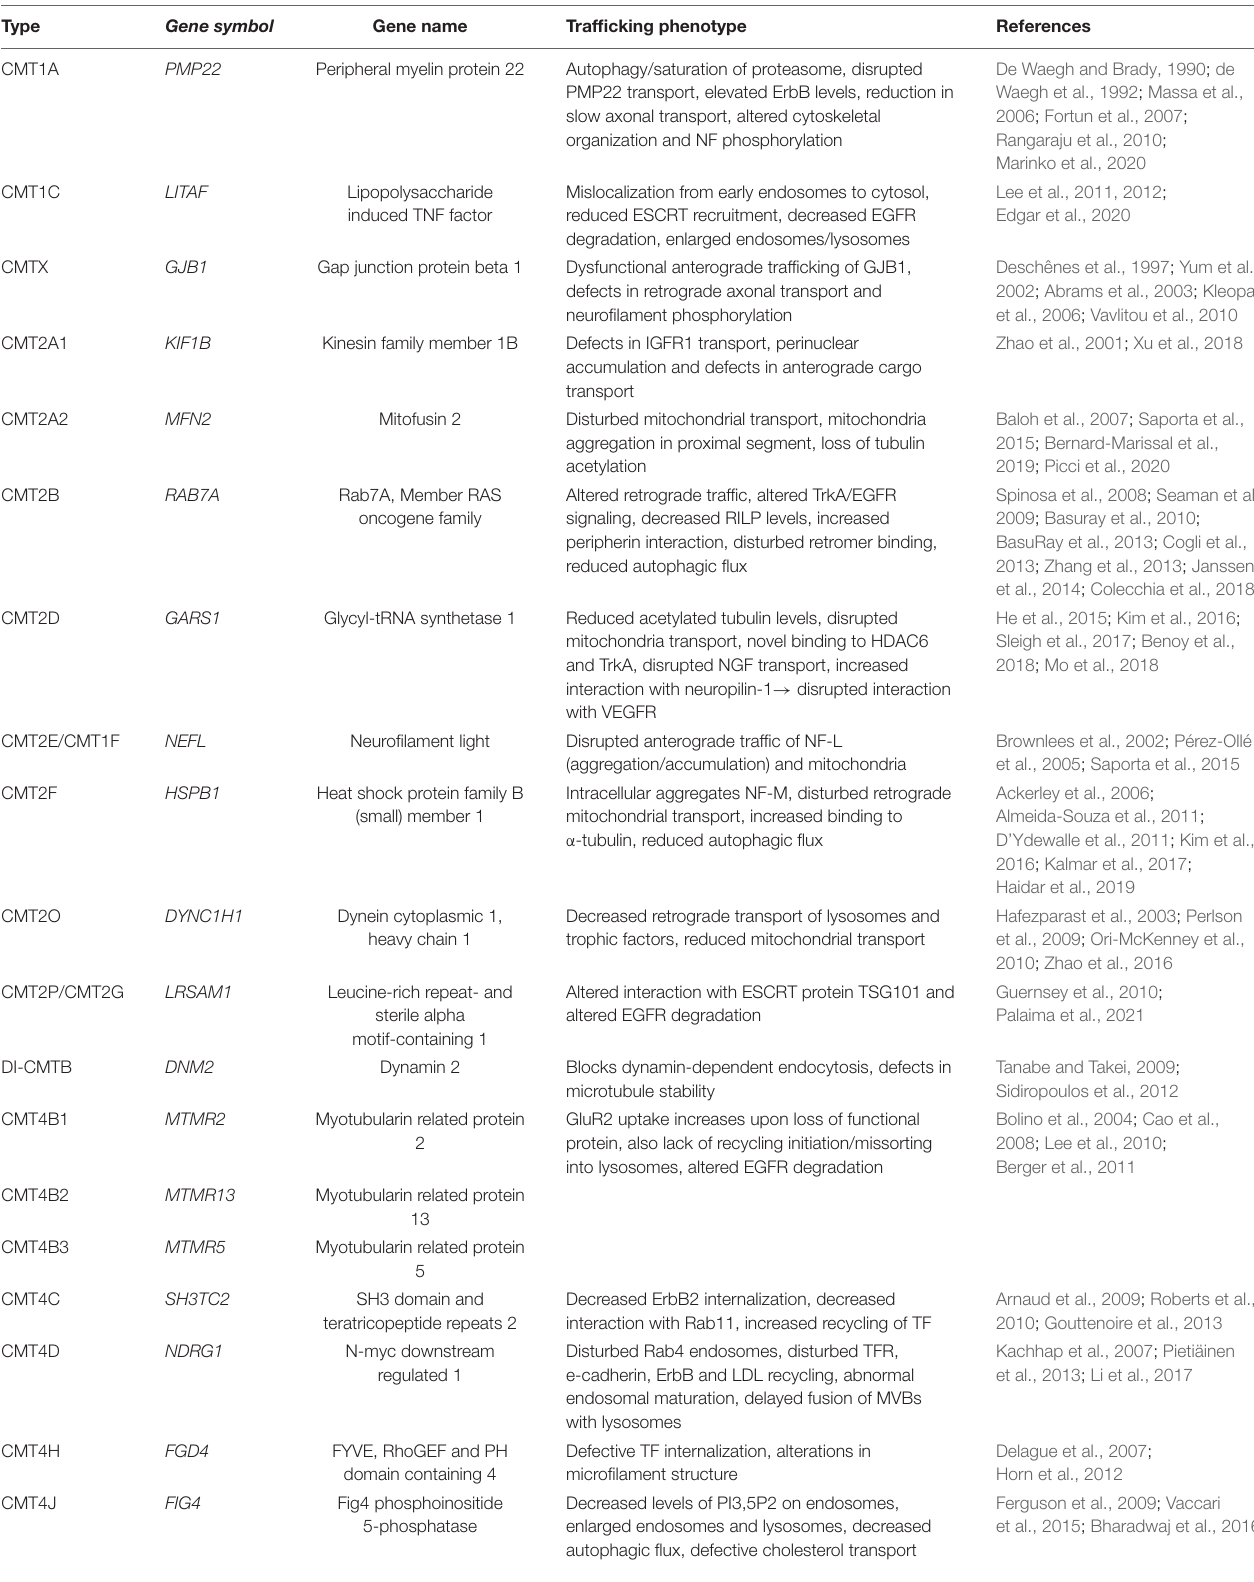
TABLE 1 | An overview of the CMT mutations involved in intracellular trafficking discussed in this review, including their relevant phenotypes.